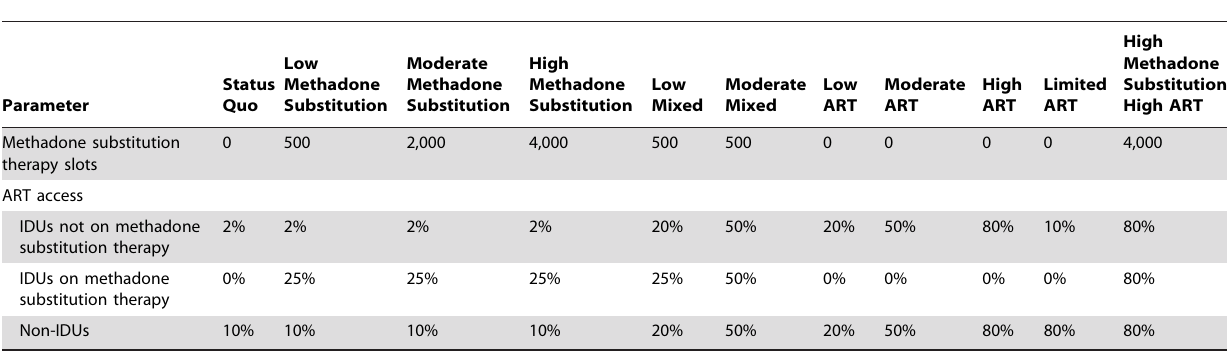
Table 2. Key parameters (methadone substitution therapy slots and ART access by population) for strategies considered.